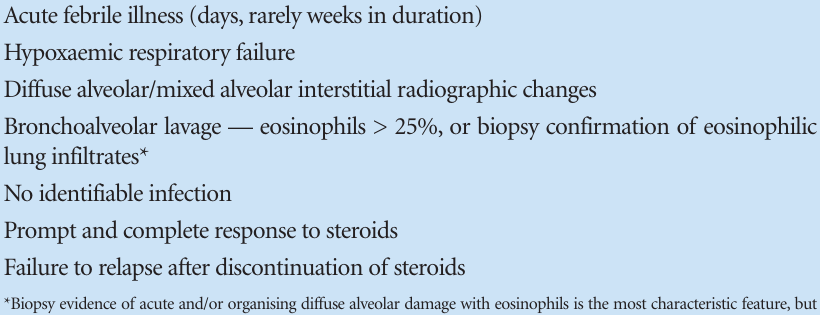
Table I.Proposed diagnosxtic criteria for acute eosinophilic pneumonia 2 Acute febrile illness (days, rarely weeks in duration) Hypoxaemic respiratory failure Diffuse alveolar/mixed alveolar interstitial radiographic changes Bronchoalveolar lavage — eosinophils > 25%, or biopsy confirmation of eosinophilic lung